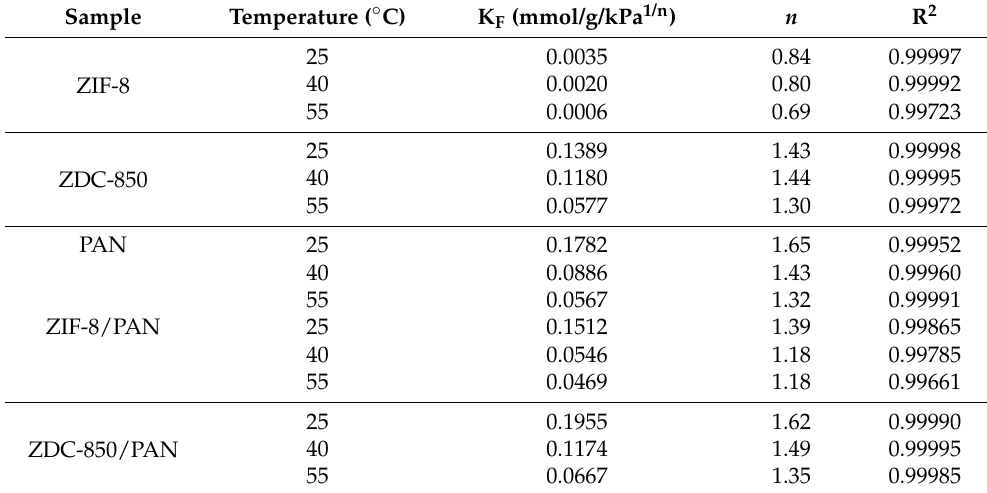
Table 5. Fitted results of the Freundlich equation for the CO 2 adsorption data collected on the samples at different temperatures.